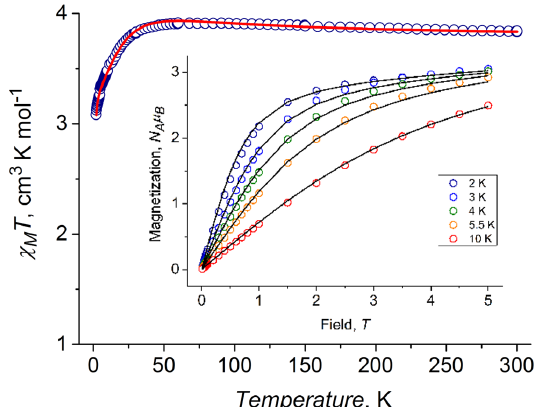
Figure 10. Temperature dependence of χ M T for 3 measured under a 1000 Oe magnetic field (open circles). Inset: Magnetization vs. field for 3 measured at T = 2, 3, 4, 5.5, and 10 K. The theoretical curves (solid lines) were calculated with the parameters shown in Table 5.